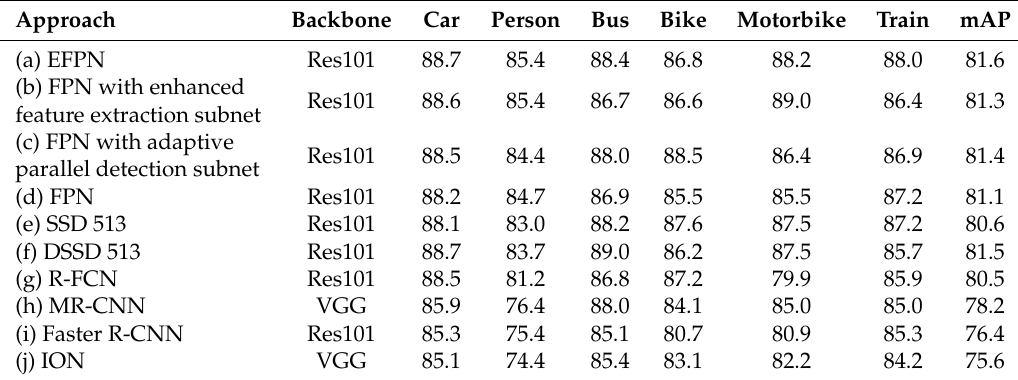
Table 1. Object detection results evaluated on